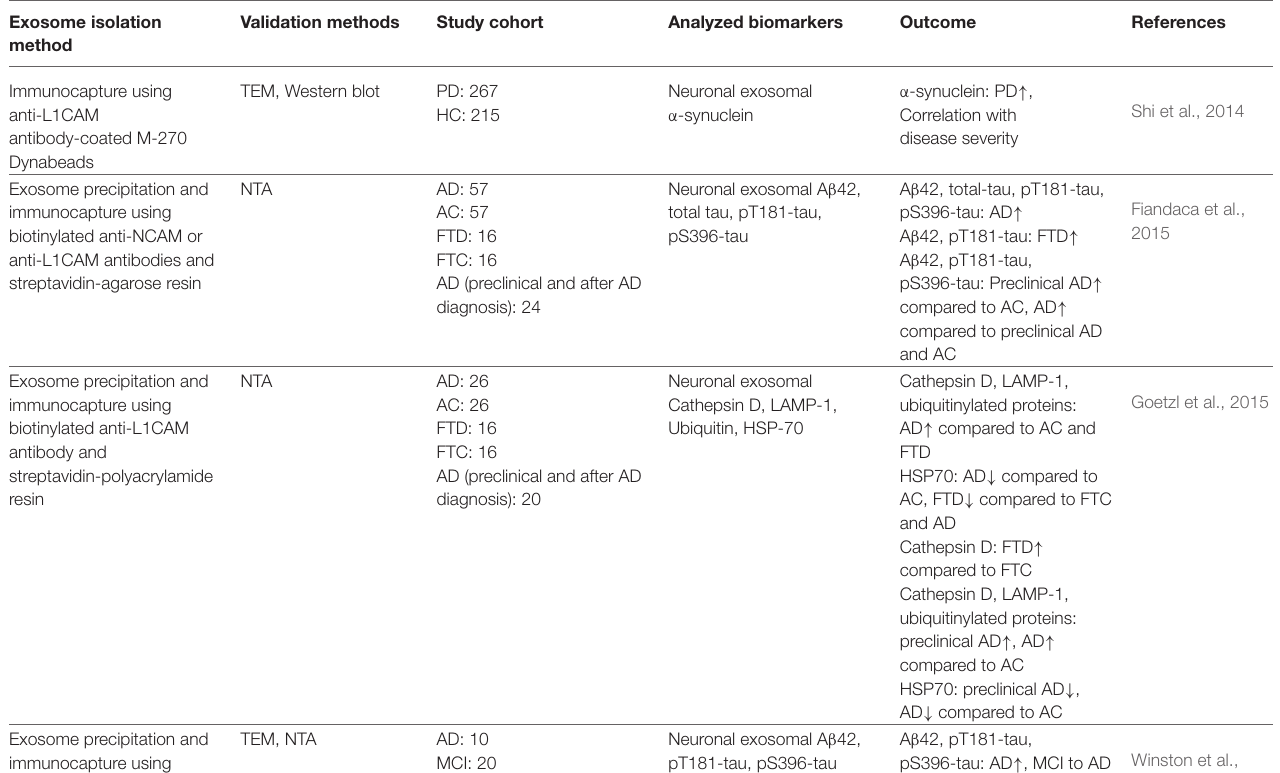
TABLE 2 | Selected publications analyzing biomarkers in CNS-derived blood